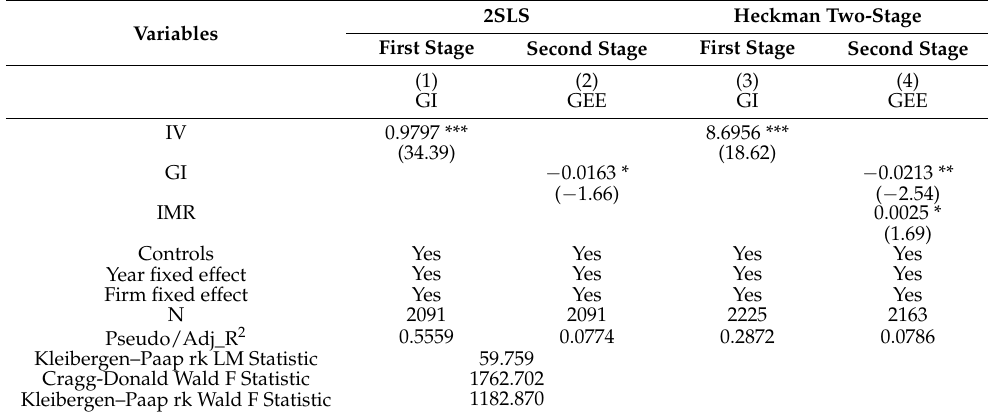
Table 4. Green innovation and green economic efficiency: 2SLS and Heckman two-stage. Variables